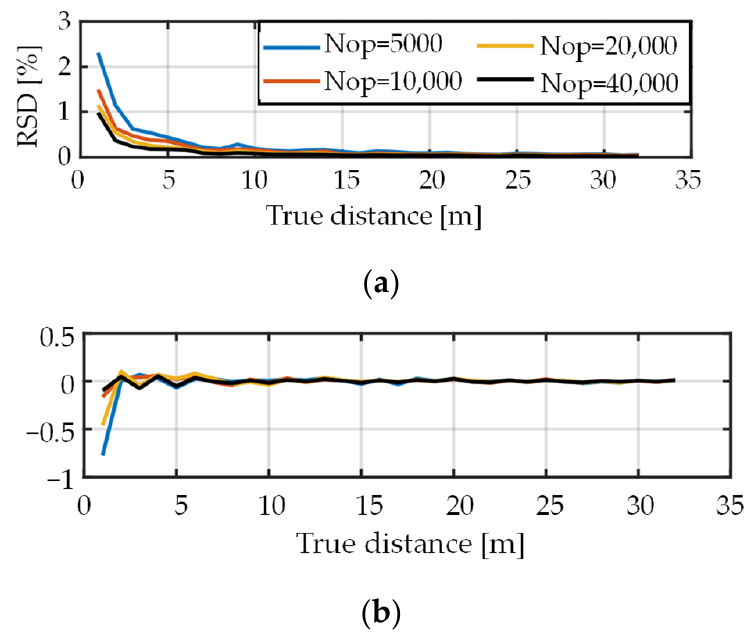
Figure 7. Results of single path simulation when depth-dependent decay of the number of photons is not considered. ( a ) Relative standard deviation and ( b ) relative mean error of the estimated depth.